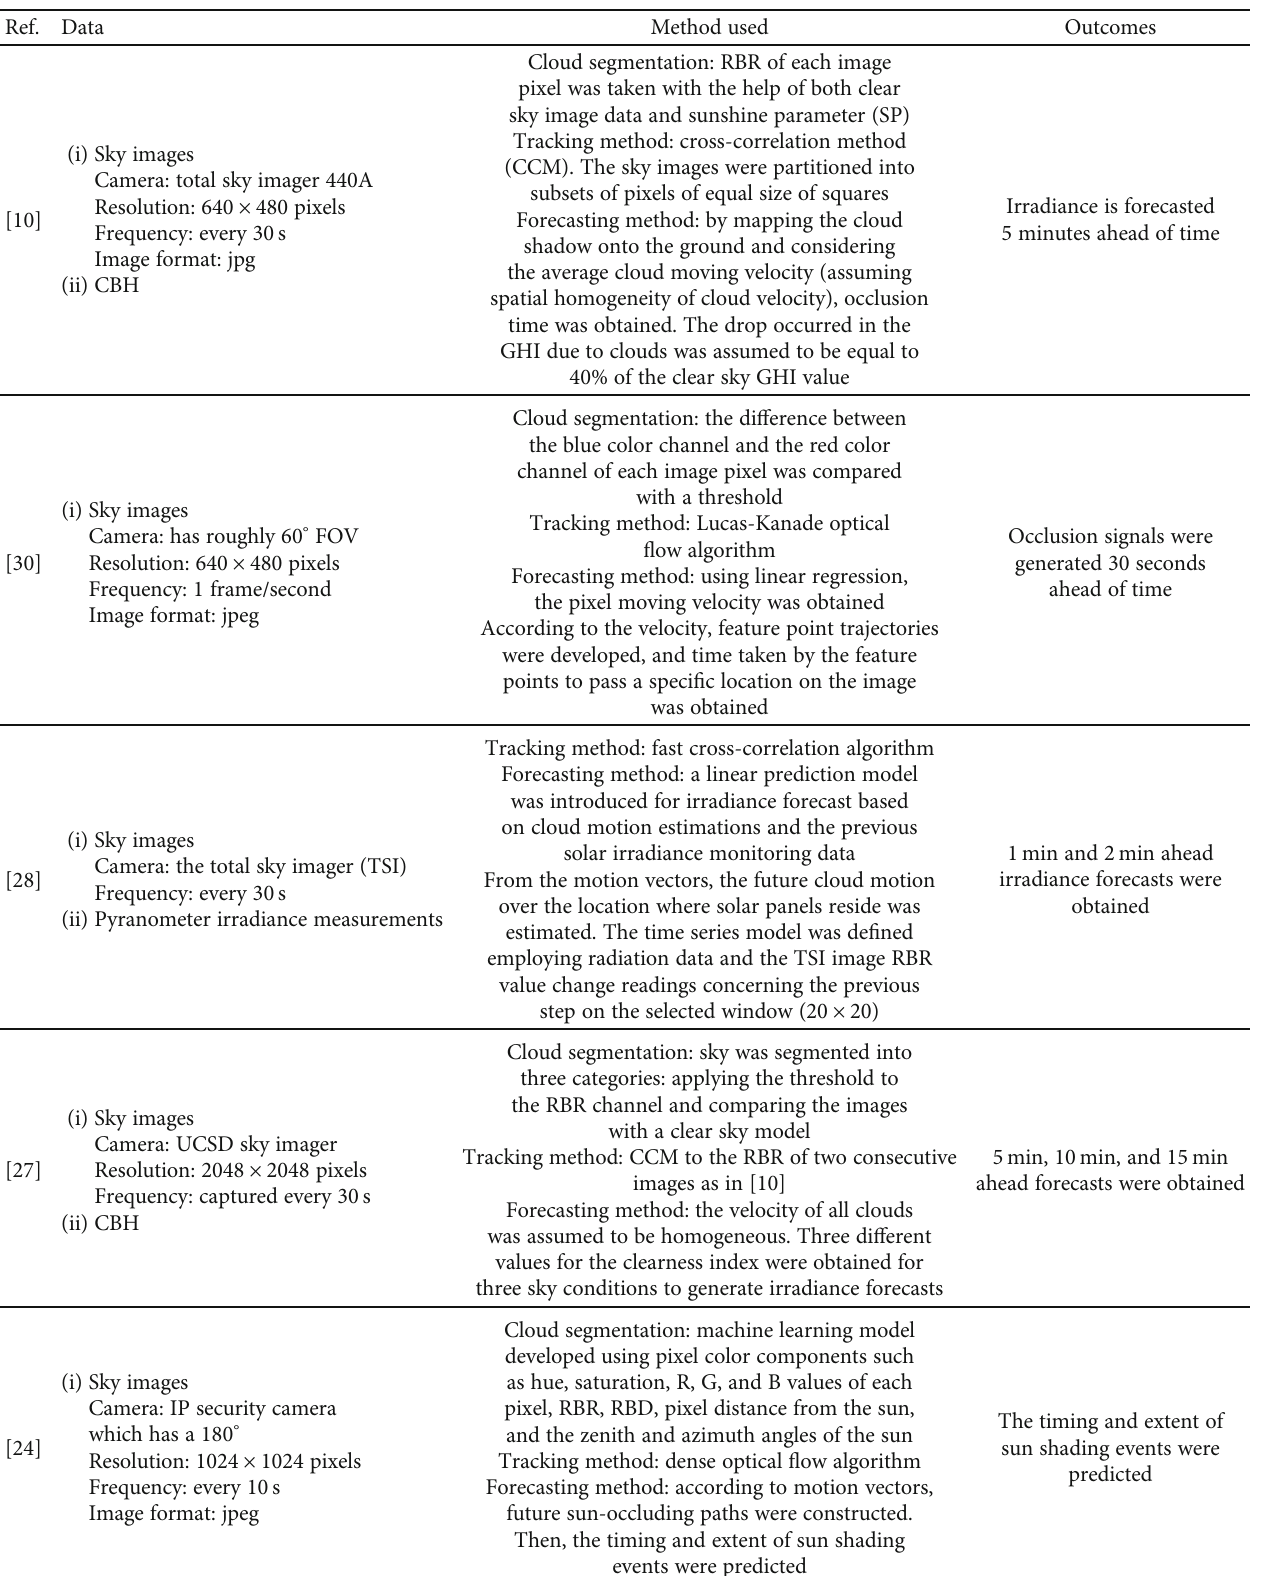
Table 1: Details of the sky image-based forecasting